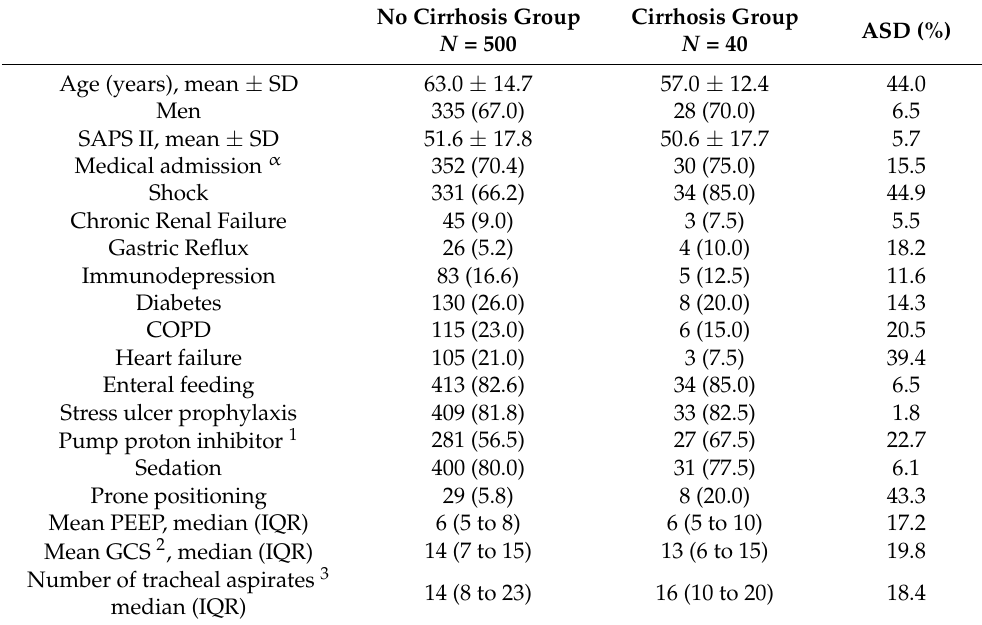
(17.9% vs. 5.8%), heart failure (7.7% vs. 15.9%), and other characteristics, such as gastric reflux (10.3% vs. 3.6%) (Table 2). Table 1. Patient characteristics according to the group.